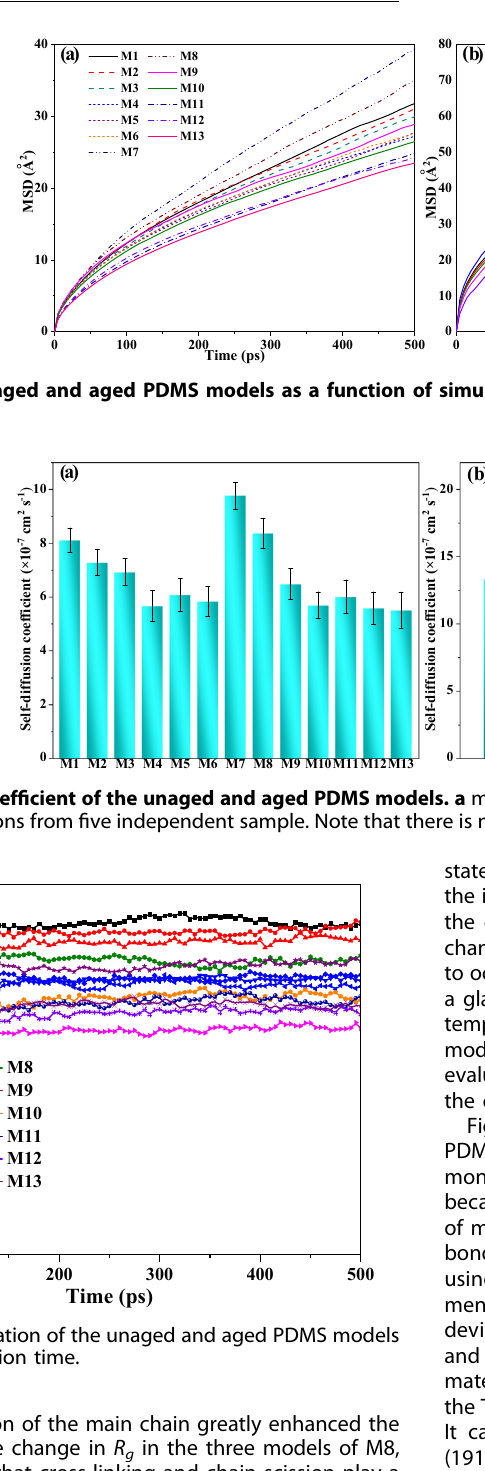
M9, and M10 signi fi es that cross-linking and chain scission play a